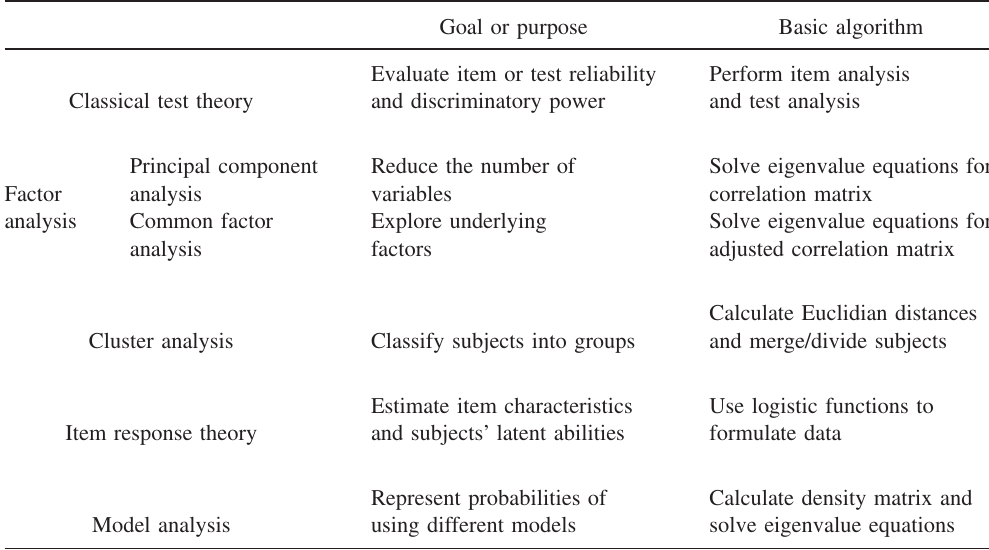
TABLE I. Five approaches to analyzing multiple-choice test